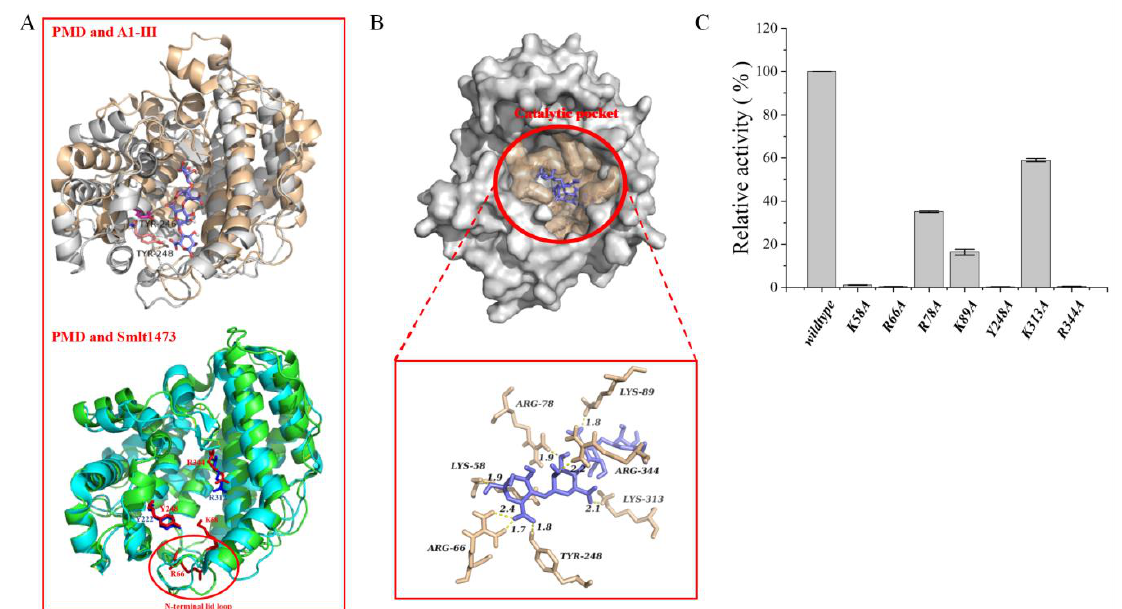
Figure 8. Results of potential critical catalytic residues of the novel alginate lyase (PMD). ( A ) Structure alignment of PMD (gray) and A1-III (wheat, polysaccharide lyase family 5 alginate lyase whose crystal structure has been solved) and the critical catalytic residues of A1-III with aligned residues in PMD (shown as stick; labeled as TYR-246 of A1-III and TYR-248 of PMD); structure alignment of PMD (green) and Smlt1473 (cyan, polysaccharide lyase family 5 alginate lyase whose crystal structure has been solved) and the critical catalytic residues of A1-III with aligned residues in PMD. (shown as stick; labeled as: Y-222 and R312 of Smlt1473, K58, R66, Y-248 and R344 of PMD); ( B ) result of molecular docking of PMD with a tetrasaccharide; ( C ) Results of relative activities of purified mutant enzymes.